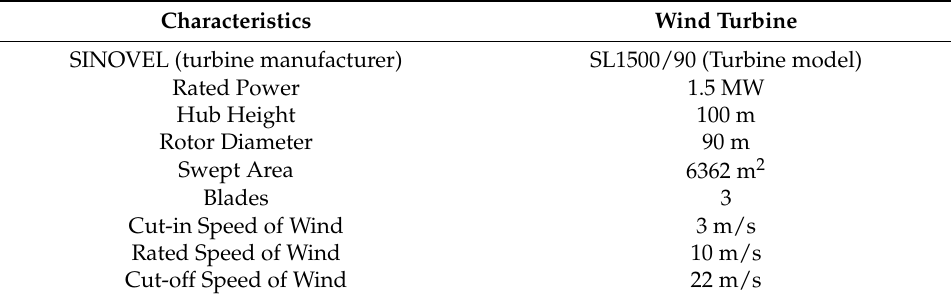
Table 2. Wind turbine technical specifications.